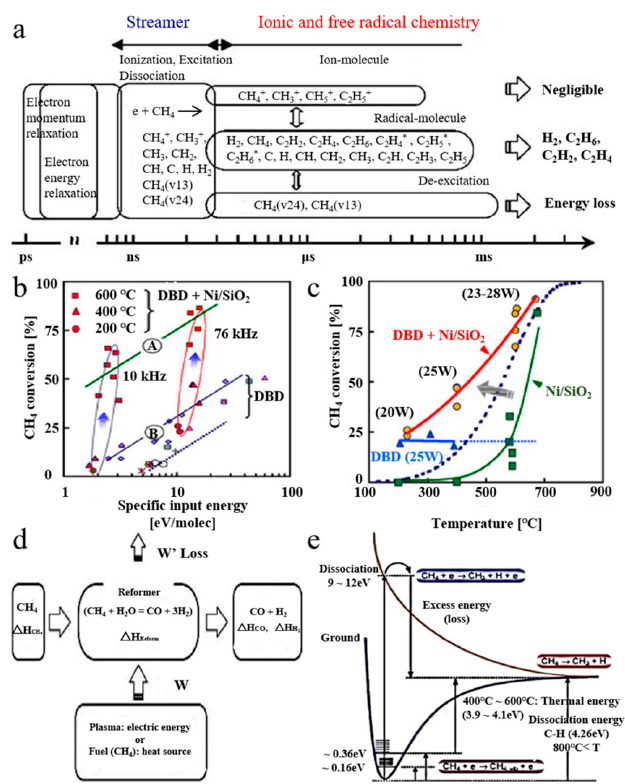
Figure 8. ( a ) reaction scheme; ( b ) CH 4 conversion: (A) barrier discharge + Ni catalyst; (B) barrier discharge; ( c ) CH 4 conversion; the blue dashed line represents the equilibrium conversion; ( d ) energy diagram; ( e ) methane activation. Reproduced with permission from [106]; Copyright Elsevier, 2004.